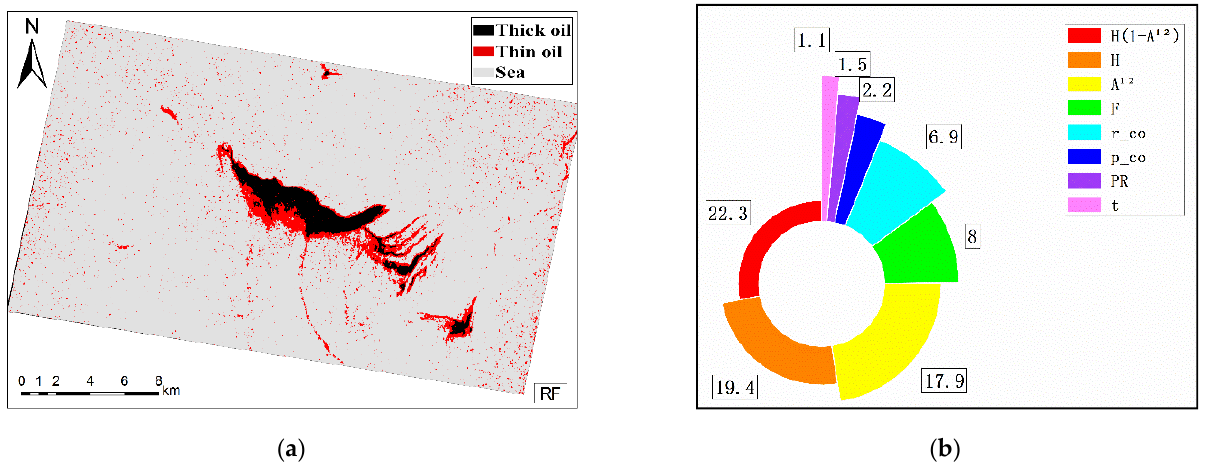
Figure 11. Results of the Random Forest classifier and importance ordering of polarimetric features in study area 1 : ( a ) oil spill detection results; ( b ) variable importance ordering. Table 4. Classification accuracies of the Random Forest classifier in study area 1.